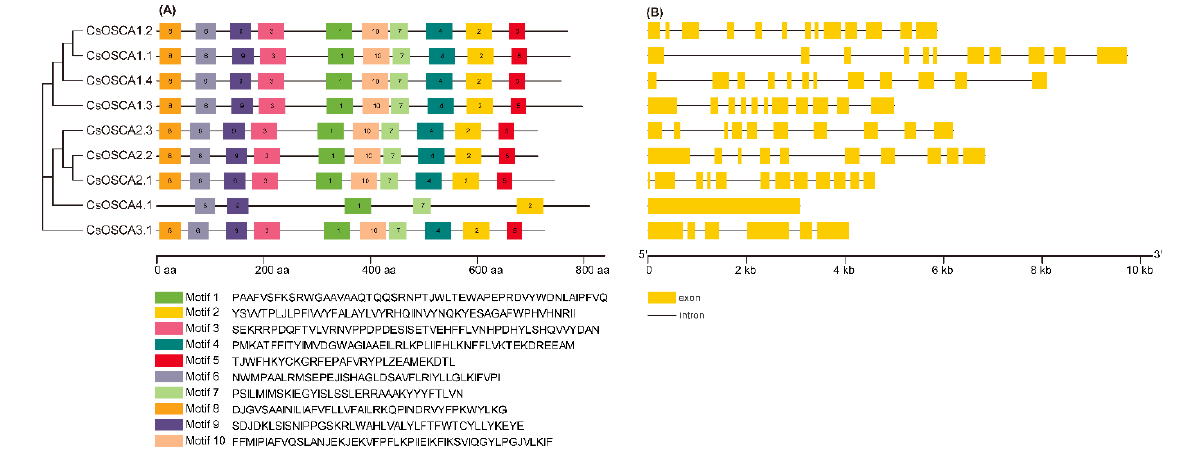
Figure 2. Conserved motif arrangement ( A ) and gene structure diagram ( B ) of OSCA gene family in cucumber based on the phylogenetic relationship. ( A ) Distribution of conserved motifs in CsOSCA proteins identified by MEME. The length and name of conserved motifs are represented by boxes with different colors and their sequences are indicated below. ( B ) Exon ‐ intron structure of CsOSCA genes. The yellow boxes and black lines represent exons and introns, respectively.